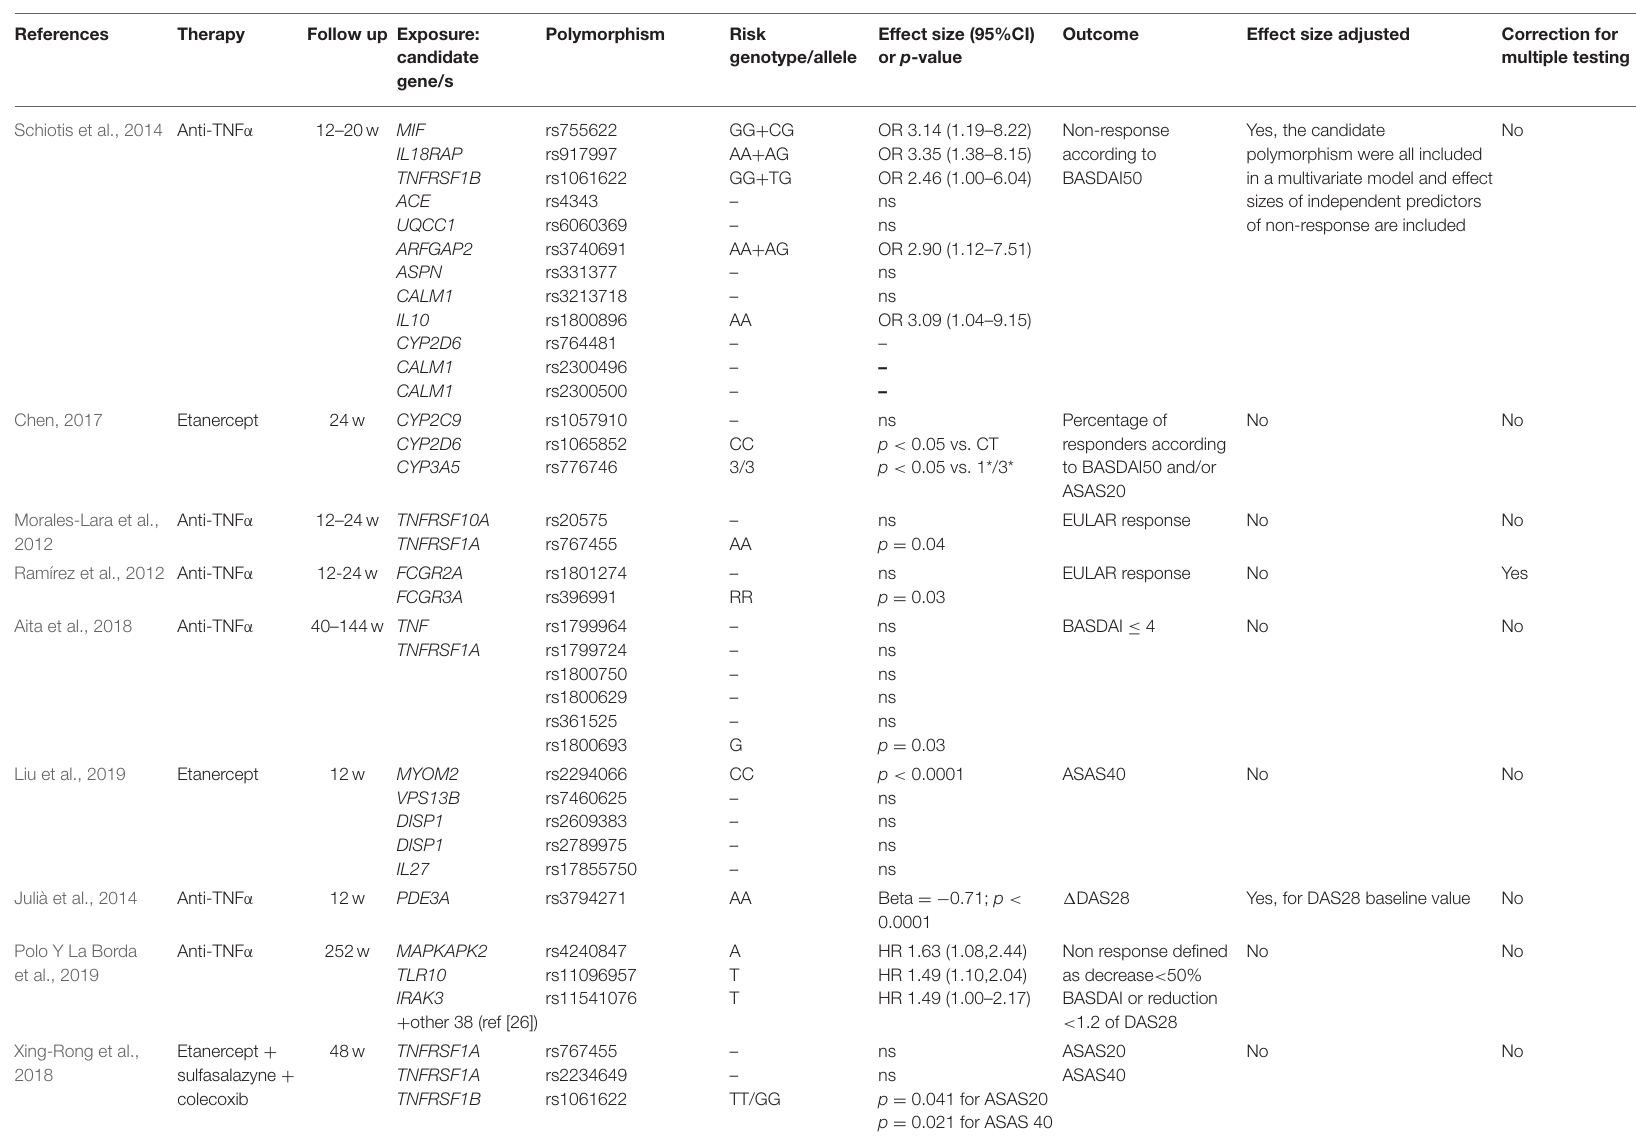
TABLE 3 | Studies included in the qualitative